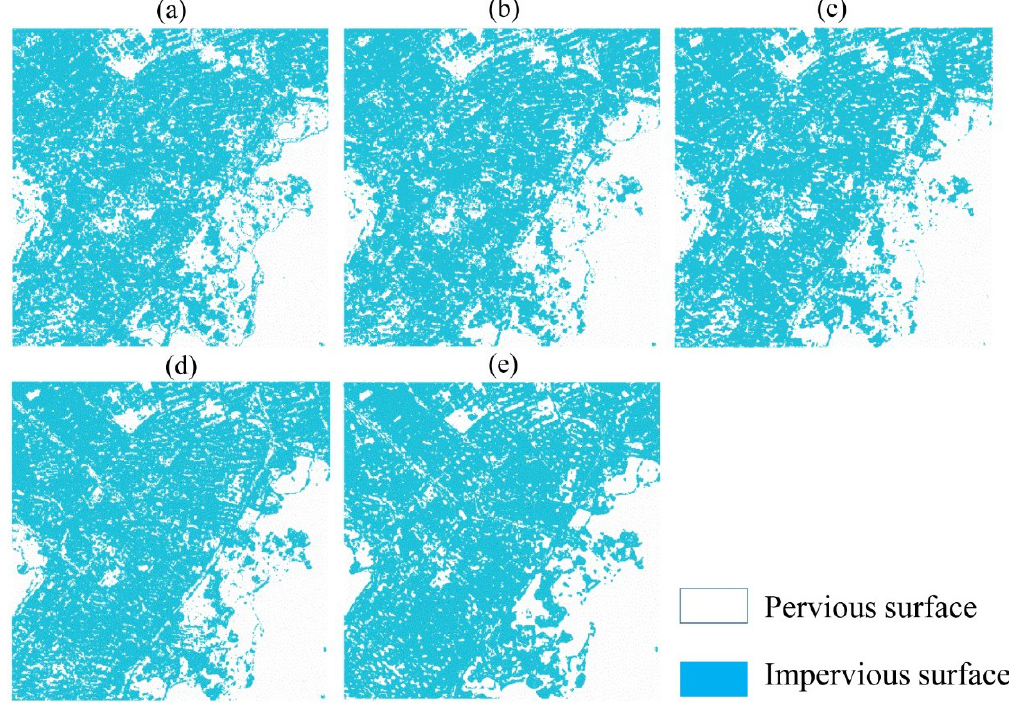
Figure 9. The IS extraction results using different images in Site 1: ( a – e ) IS results of IHS, GTF, DWT, IHS-GTF, and the Sentinel-2A image, respectively.